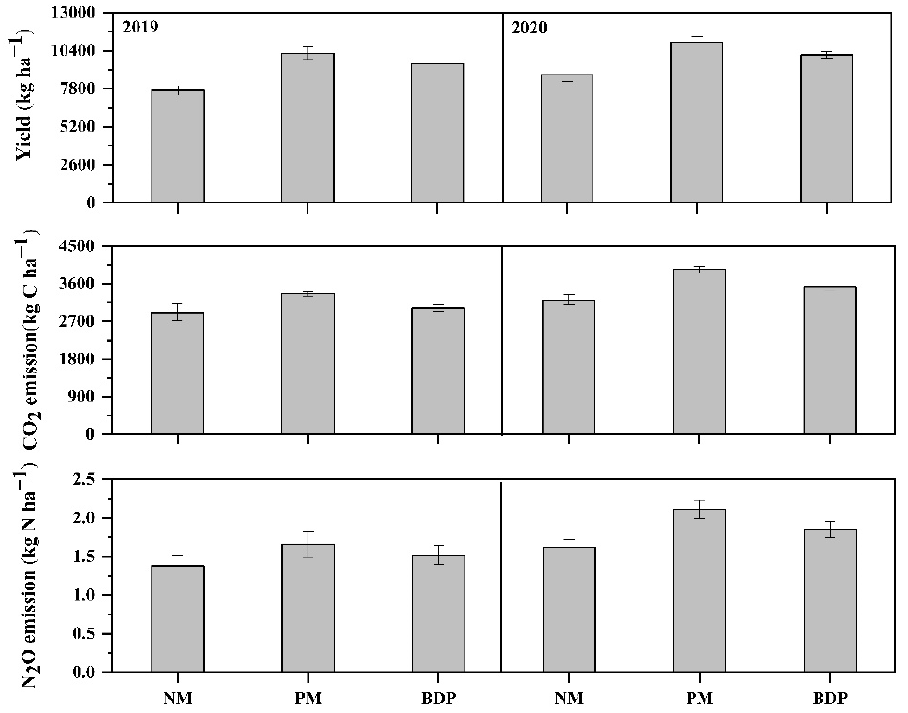
Figure 3. The maize yield, CO 2 and N 2 O emissions in NM, PM and BDP treatment cultivation systems. BDP induced lower soil CO 2 and N 2 O emissions during the growing periods than